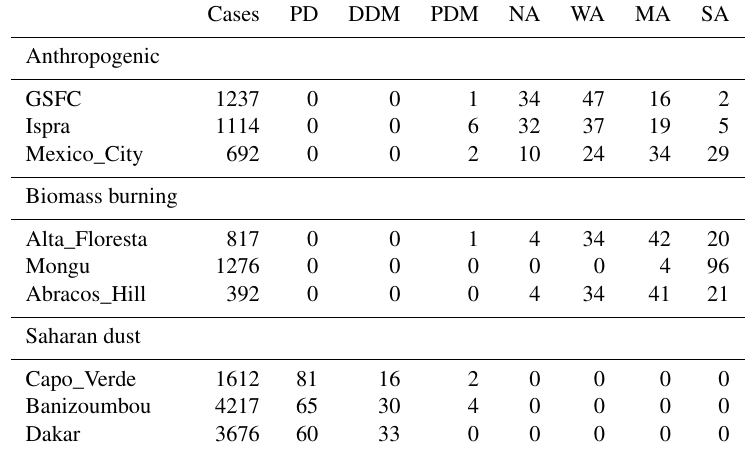
Figure 5. Mean volume size distributions (a) and spectral SSA (b) for the aerosol-type sectors identified in Fig. 4. Black lines relate to pure dust (solid lines and circles) and dust-dominated mixtures (dashed lines, open circles, and triangles) while grey lines mark pollution (solid lines and squares) and pollution-dominated mixtures (dashed lines, open squares, and diamonds). Table 3. Occurrence rate (in percent) of the aerosol types identified with our method at the AERONET sites given in the lower half of Table 1.